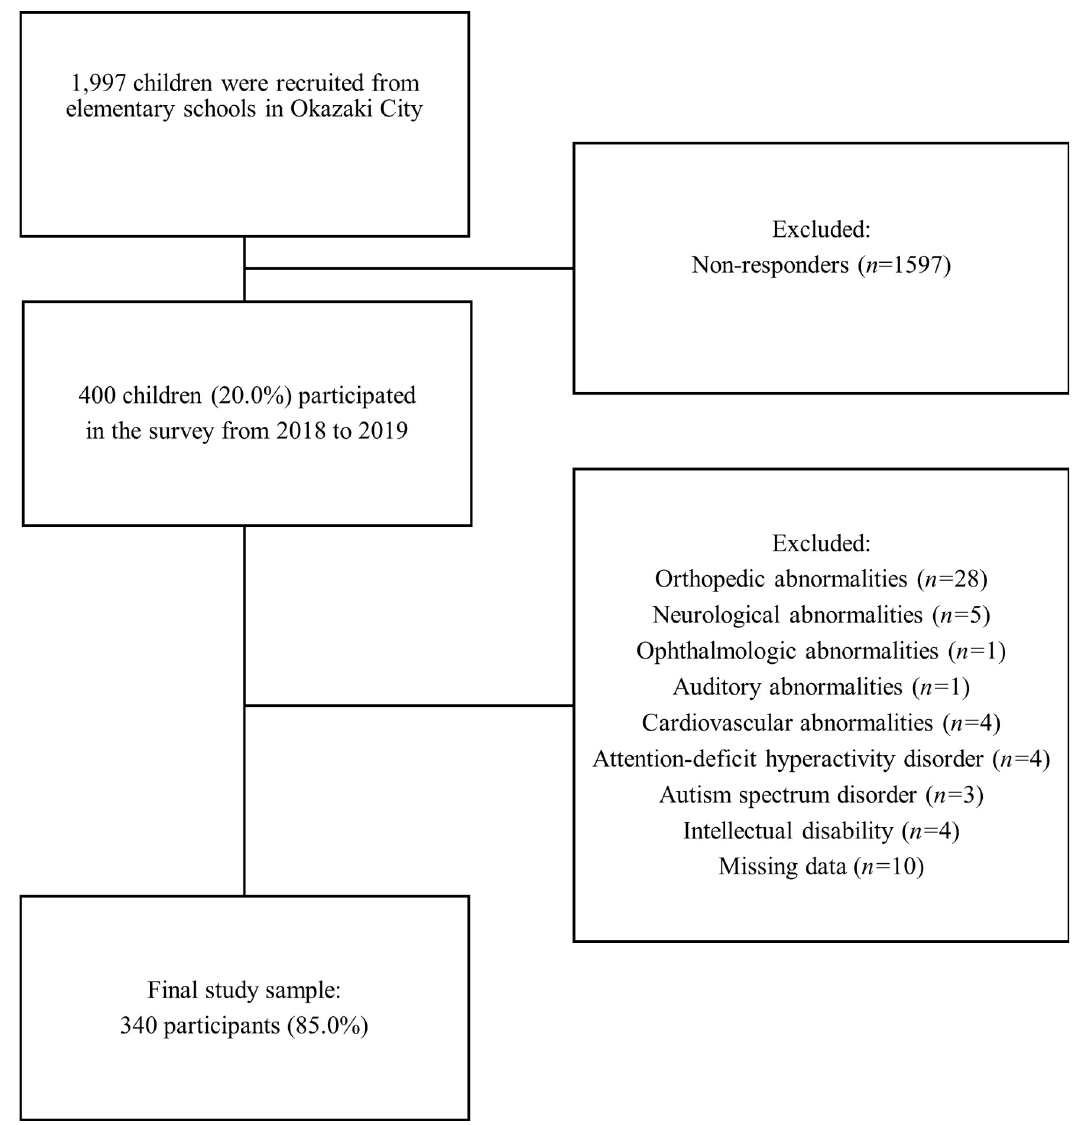
Fig 1. Flowchart of the enrollment of study